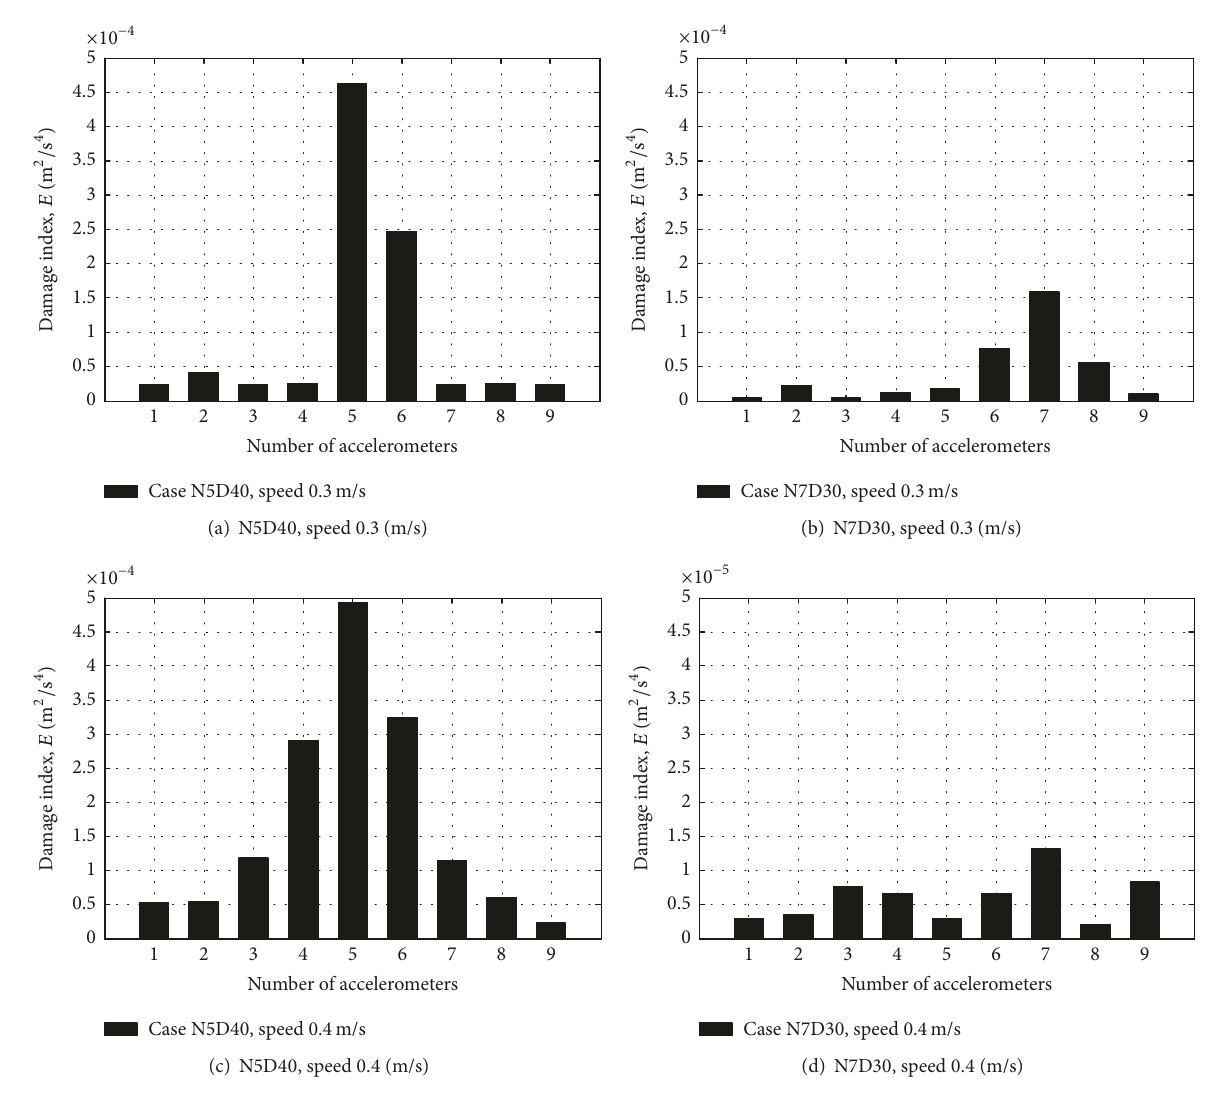
Figure 17: Scalar values of the damage index 𝐸 𝑛 for all accelerometers at different locations and load moving velocities, as obtained from laboratory test data: (a) case N5D40 (velocity = 0.3 m/s), (b) case N7D30 (velocity = 0.3 m/s), (c) case N5D40 (velocity = 0.4m/s), and (d) case N7D30 (velocity =